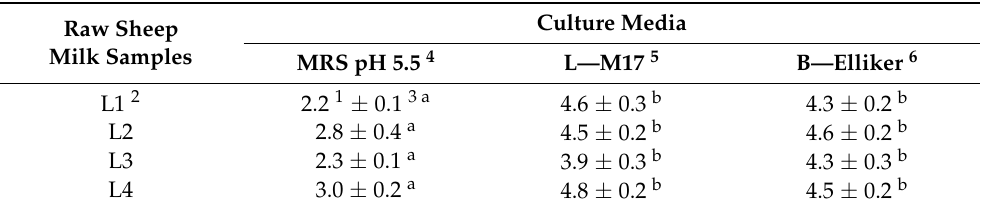
Table 2. Viable colony counts of thermophilic LABs from Sardinian raw sheep milk samples plated on MRS pH 5.5, L-M17, and B-Elliker in anaerobic conditions at 45 ◦